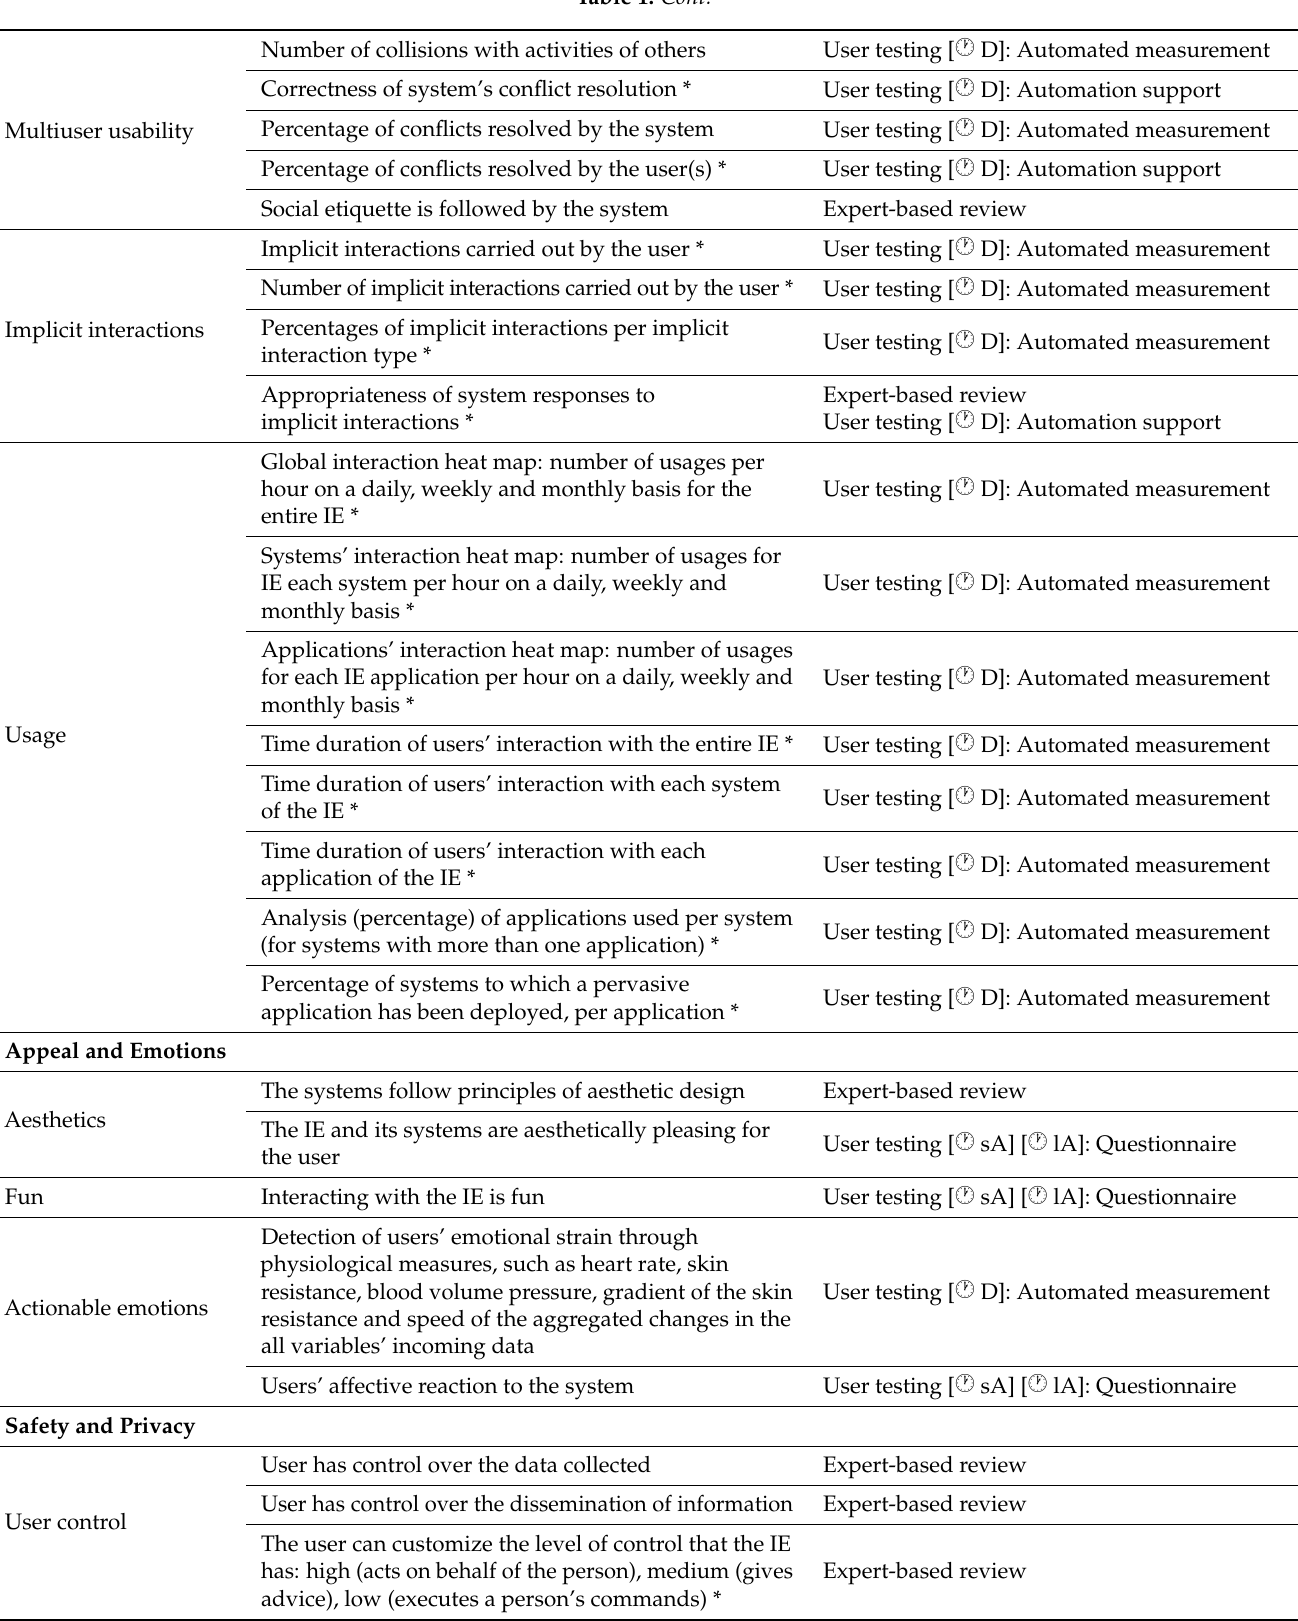
Table 1. The UXIE framework: concepts, attributes, metrics and methods. Asterisk (*) denotes metrics that are novel in the UXIE framework.